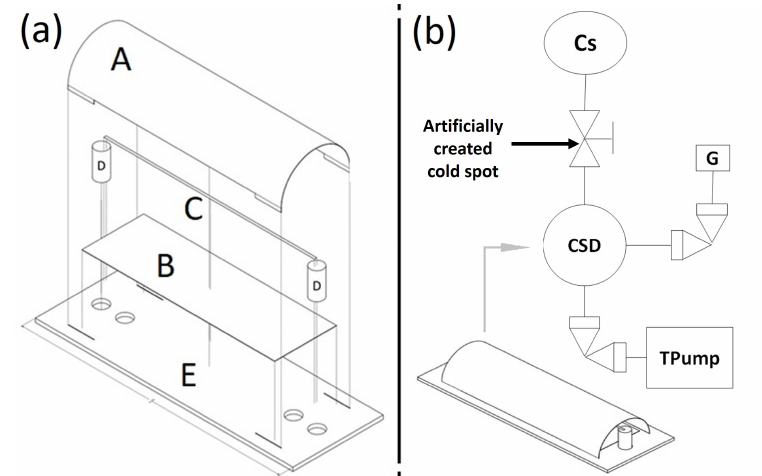
Figure 2. ( a ) On the left, the exploded assembly of the gauge. There are copper wires that were not depicted connecting the cylindrical (A) and flat (B) copper plates, as well as the filament ends, to independent pins in a feedthrough. The filament (C) is connected to screws which act as leads (D). All elements are isolated from each other through ceramic beads and boards like the base ceramic support (E). ( b ) On the right, a scheme of the manifold assembly. Label CSD indicates the cross chamber where the gauge is located, Cs indicates the cesium source chamber, TPump is the turbopump and G is a pressure gauge. The copper wires connecting the gauge to the feedthrough are thick enough to support the structure without it dipping and touching the manifold. The cold spot is located 1 ft away from the